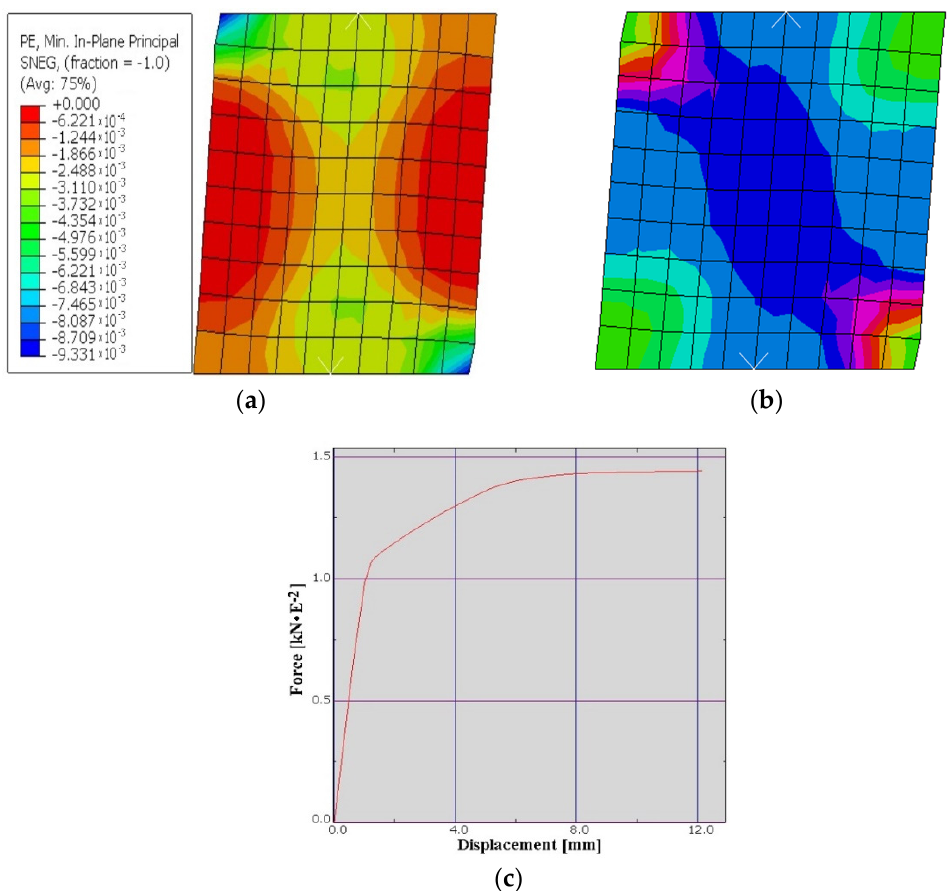
Figure 4. Compression plastic strain ( a ); strain components at integration point ( b ); graph of force– displacement to VHB ( c ).